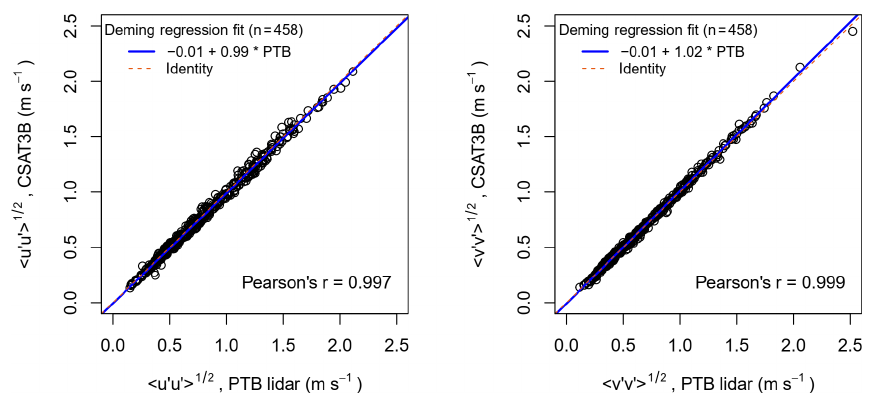
Figure A1. Comparison for the standard deviation of the u ve- locity component (a) and the standard deviation of the v veloc- ity component (b) , including the regression equation and correla- tion coefficient. The solid blue line indicates the Deming regression and the dashed red line indicates identity. For u (cid:48) u (cid:48) − 0 . 008ms − 1 and RMSE is 0.028ms − 1 , and for v (cid:48) v (cid:48) 0 . 5 , the bias is 0.003ms − 1 and RMSE is 0.018ms − 1 .